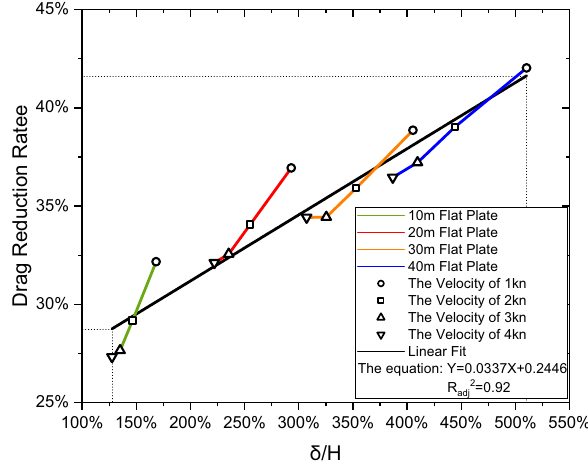
Figure 13. Linear fitting for the drag reduction rate versus boundary layer thickness to remora height